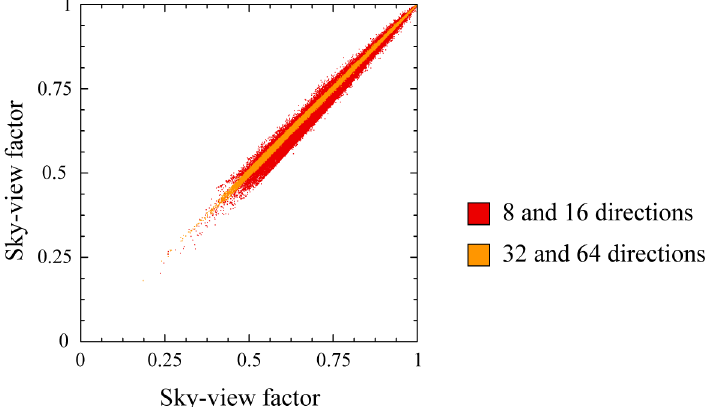
Figure 4. Scatterplots comparing SVF estimated in 8 and 16 directions (red), and 32 and 64 directions